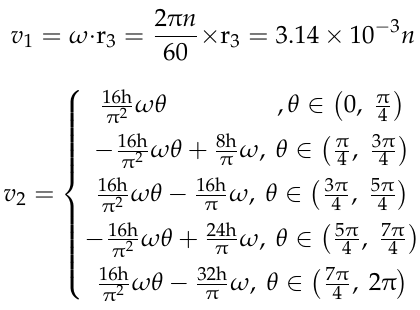
Figure 2. Schematic configuration of the pump transmission sets: ( a ) main piston transmission set; ( b ) annular piston transmission